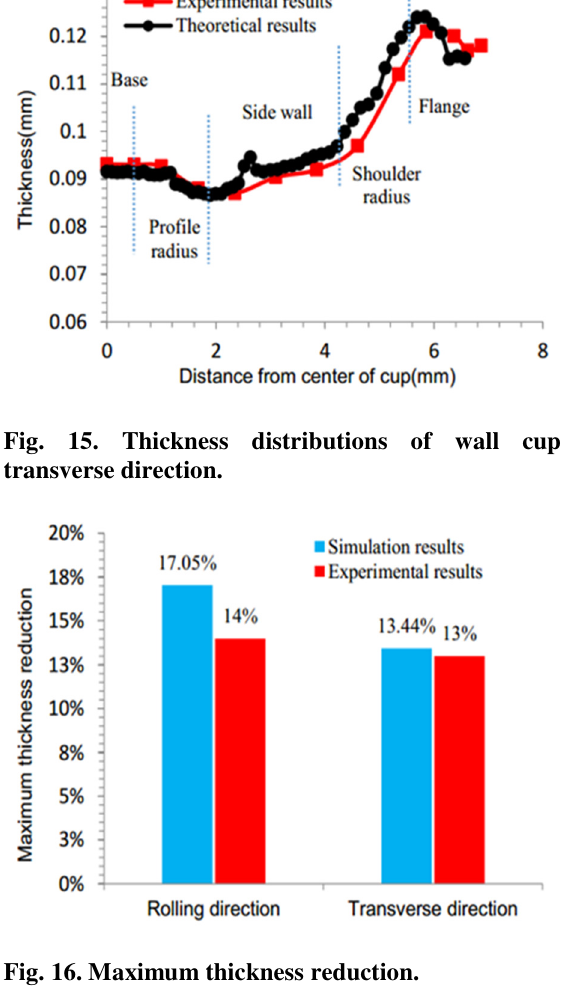
Fig. 16. Maximum thickness reduction.